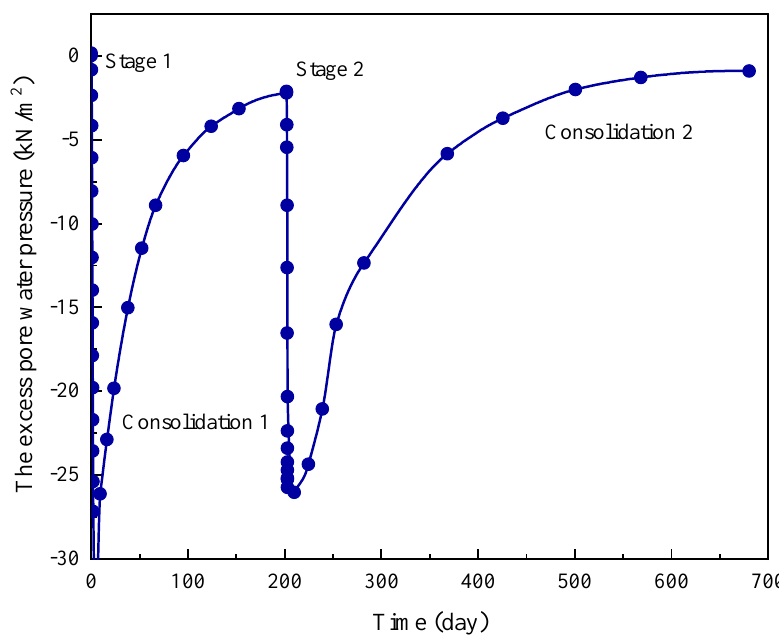
Figure 15. Line chart of excess water pressure change process during consolidation.